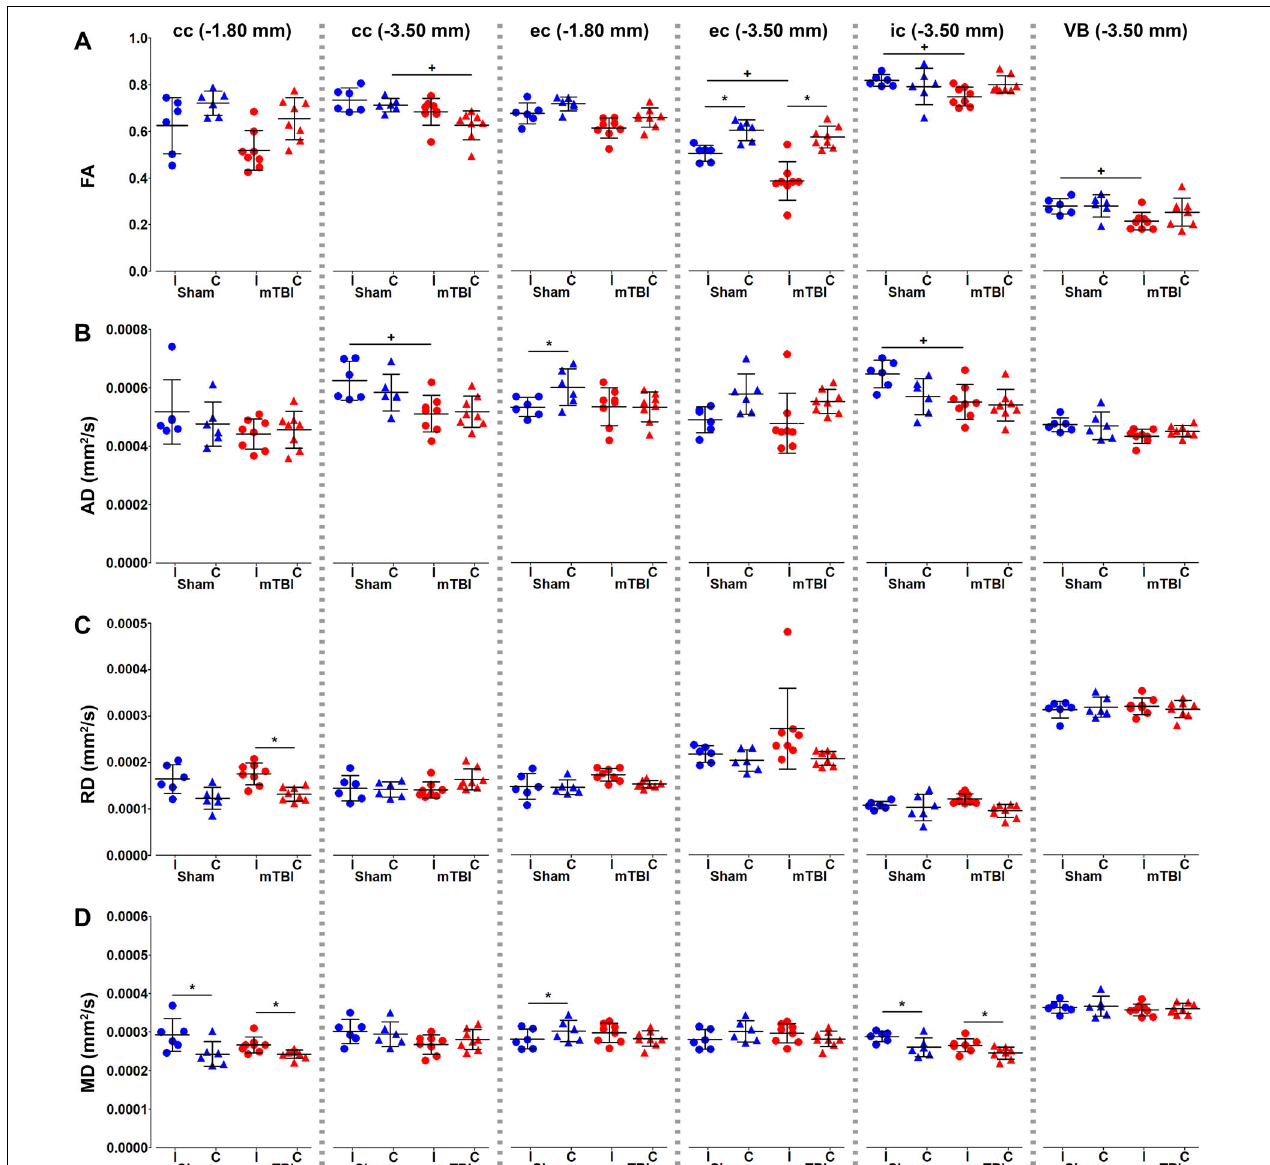
FIGURE 4 | Diffusion tensor imaging (DTI) metrics, fractional anisotropy (A) , and axial (B) , radial (C) , and mean (D) diffusivities, were analyzed in the corpus callosum and external capsule at –1.80 and –3.50 mm, and the internal capsule and ventrobasal complex at –3.50 mm from bregma. Sham-operated animals are indicated in blue and mTBI in red, while ipsi- and contralateral hemispheres are represented by circles and triangles, respectively. Results are shown as mean and standard deviation, and paired (*) t -test comparing ipsi- and contralateral sides within animals (* q < 0.05) or unpaired (+) t -test comparing the same hemisphere between sham-operated and mTBI rats ( + q < 0.05), both FDR-corrected. AD, axial diffusivity; cc, corpus callosum; ec, external capsule; FA, fractional anisotropy; MD, mean diffusivity; RD, radial diffusivity; ic, internal capsule; VB, ventrobasal